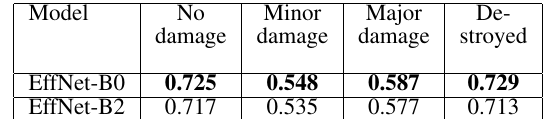
Table 2. Synthesis of damage classification results (F1 score)